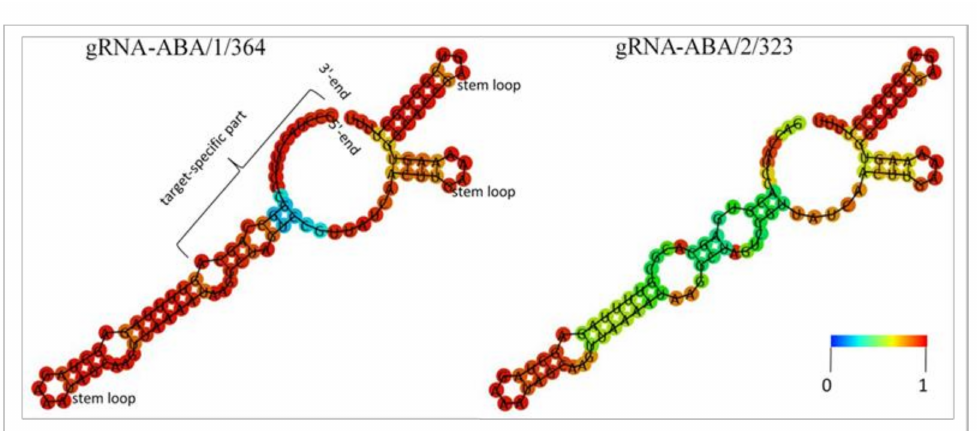
Figure 3. Secondary structure models of guide RNAs. Two-dimensional models of the minimum free energy structures of gRNA-ABA/1/364 and gRNA-ABA/2/323 as generated by the RNAfold online platform (http://rna.tbi.univie.ac.at/cgi- bin/RNAWebSuite/RNAfold.cgi (accessed on 25 April 2021)) [26]. RNA ends, target-specific part and essential stem loops are indicated only for gRNA-ABA/1/364 but apply likewise for the other as well. The color code represents the base-pairing probabilities of individual nucleobases. For unpaired bases, the colors denote the probabilities of being